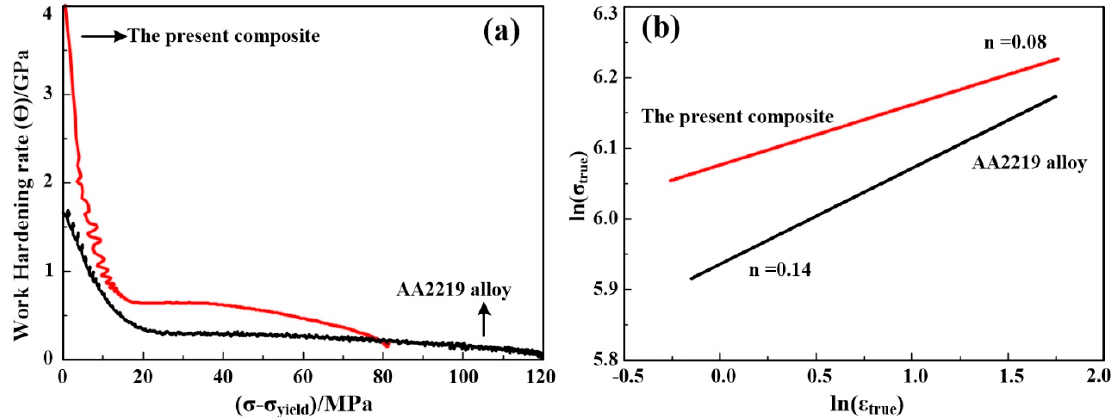
Figure 9. ( a ) Kocks–Mecking plots and ( b ) the ln( σ true )-ln( ε true ) curves for AA2219 alloy and 5 wt.% nanosized TiB 2 /AA2219 composite.